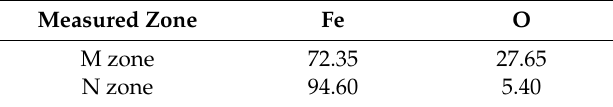
Figure 5. Morphology of wear debris when the RD was not used; H = 26.1 × 10 3 A/m. ( a ) Macro- photograph and ( b ) scanning electron microscope (SEM) image. T able 1 Chemical components of the wear debris (at.%).